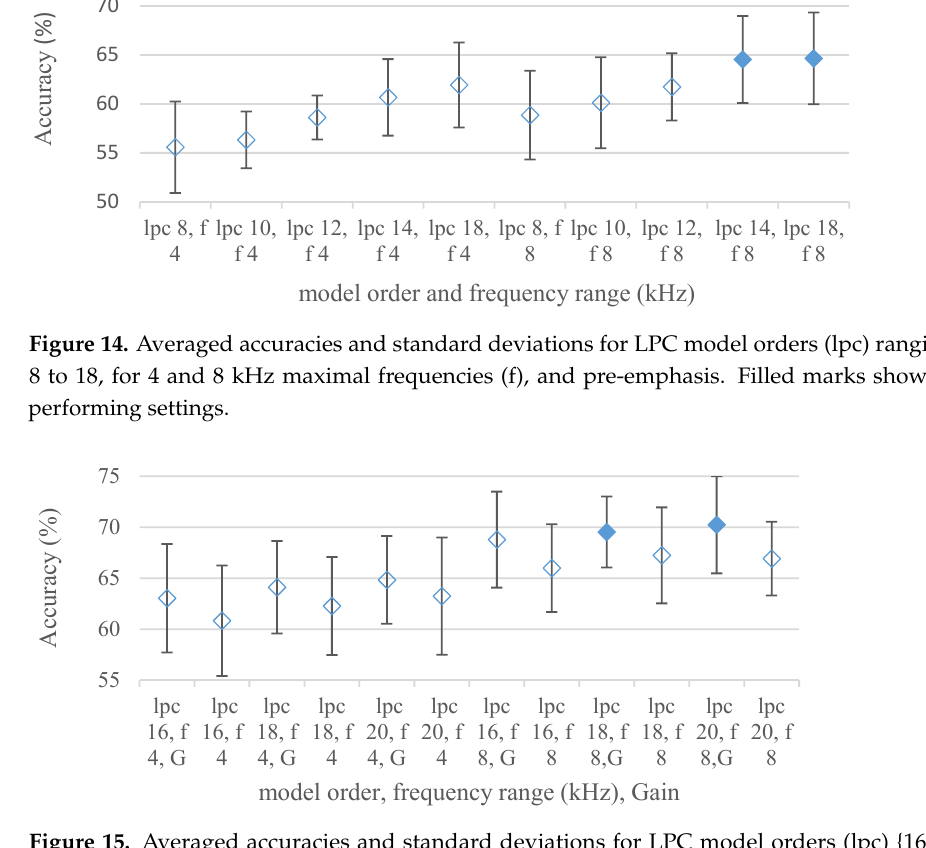
Figure 15. Averaged accuracies and standard deviations for LPC model orders (lpc) {16, 18, 20}, maximal frequency (f) {4, 8 kHz}, with and without gain (G), and no pre-emphasis. Filled marks show equally performing settings.